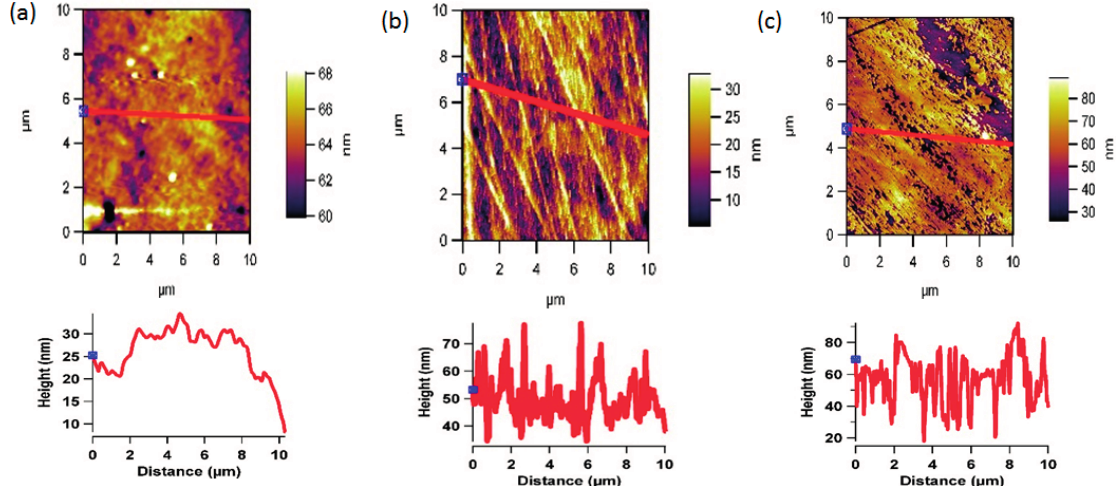
Figure 6. Representative 2D non-contact mode AFM images (10 µm × 10 µm) and line profiles for PEEK after ( a ) 10, ( b ) 20, and ( c ) 30 min of oxygen plasma treatment.